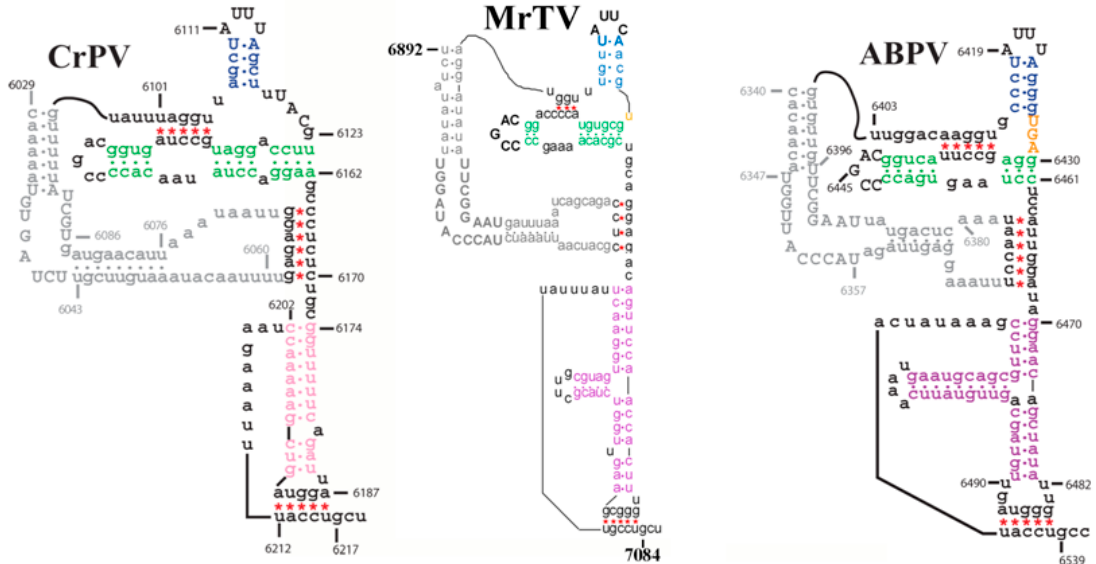
Figure 5. Structure of the intergenic region (IGR) internal ribosome entry site (IRES). The structure of the IGR-IRES in MrTV genome was predicted using the Mfold web server (http://mfold.rna.albany.edu//?q=mfold/RNA-Folding-Form). MrTV had a bulge sequence (UGGAUACCCAU and UAAGGCUU) in the IGR IRES. Additional stem loop structures and nucleotide sequences in the bulge regions were present in MrTV (indicated in bold). The red stars and dots indicate nucleotide interactions in pseudoknots and stems. The different color styles correspond to the different stems. CrPV (cricket paralysis virus; type species of Cripavirus ), ABPV (Acute bee paralysis virus; type species of Aparavirus ).